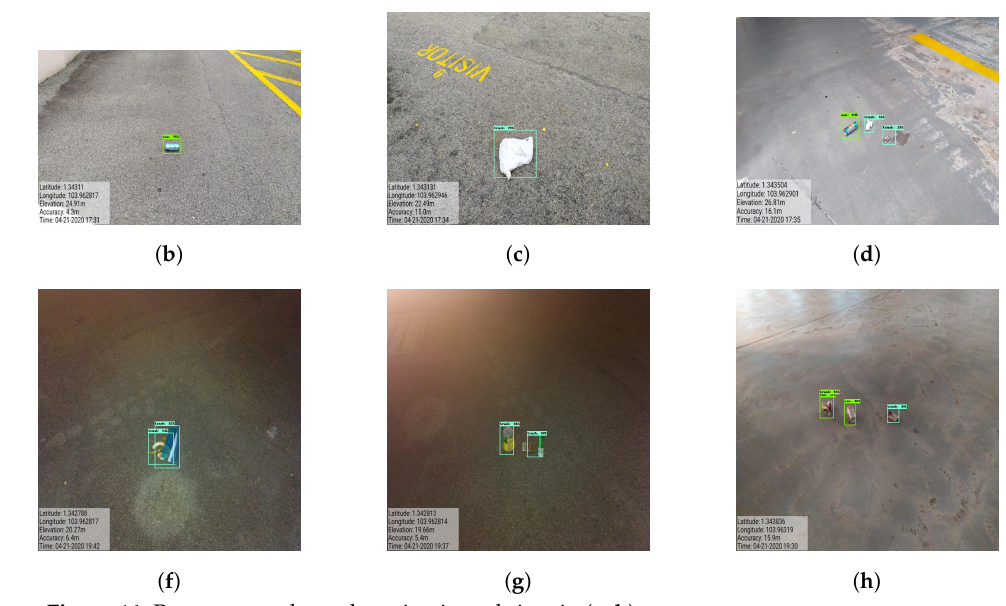
Figure 14. Pavement garbage detection in real-time in ( a – h